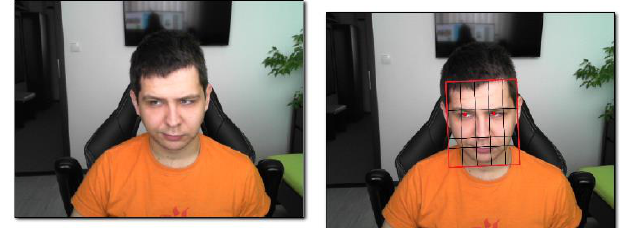
Figure 1. Face detection and eyes detection with masking operation